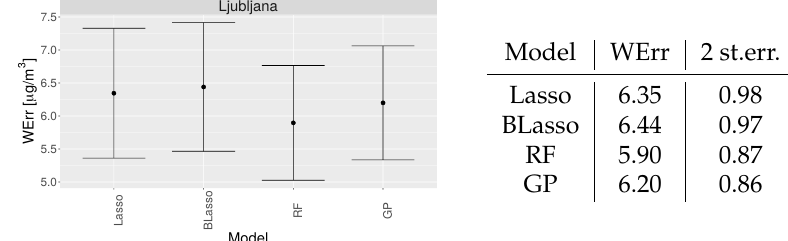
Figure 6. Figure on the left shows WErr with two standard errors for different models trained and tested on the same data (PM 10 in Ljubljana) the used models are Lasso–L1-regularized regression, BLasso–Bayesian lasso, RF—random forest, GP—Gaussian process. The table on the right shows the numerical values (WErr—calculated as described in Equation (3), 2 st. err—two standard